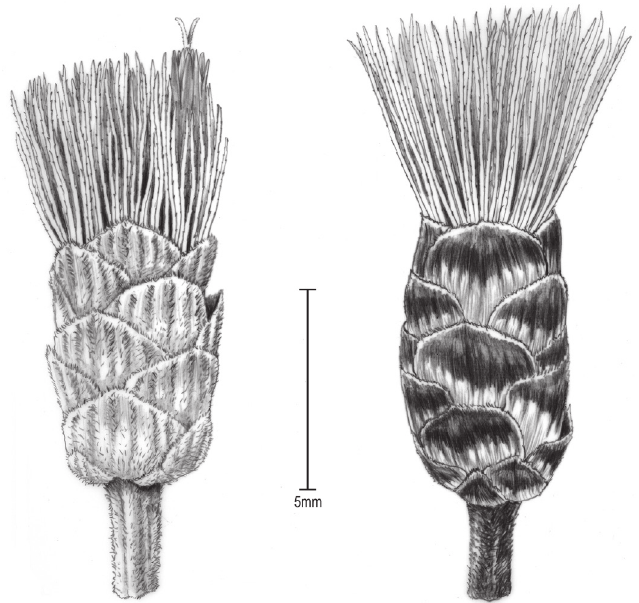
Figure 3. Illustration of heads from the holotype: A Head when in flower B Head with mature achenes. Note: there is an increase in dark coloration on the more mature head, possibly caused by fungi. [Illustration by Alice Tangerini